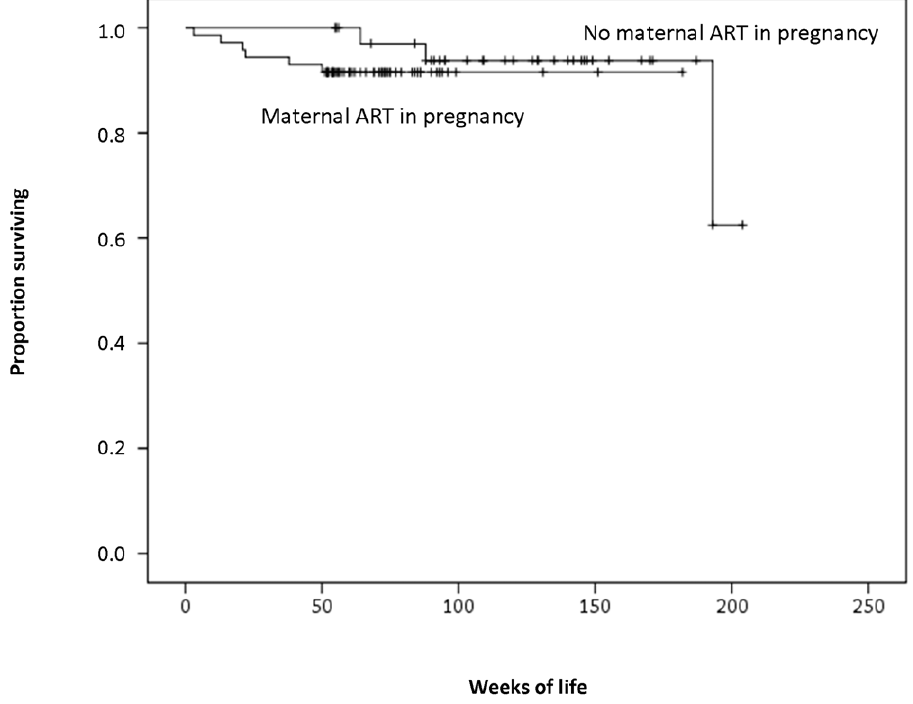
Figure 3. Kaplan-Meier Curves for infant survival with and without maternal ART in pregnancy.